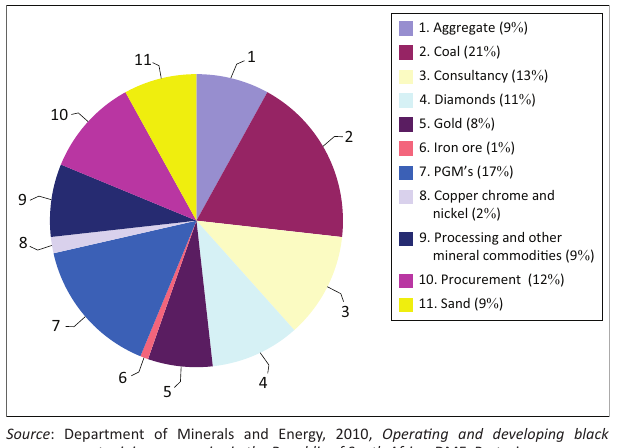
FIGURE 3: Number of black economic empowerment companies by commodities. FIGURE 4: Market capitalisation by value of listed mining companies (July